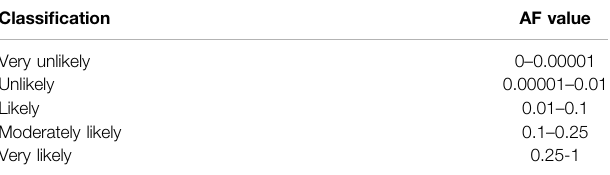
TABLE 1 | Leaching potential